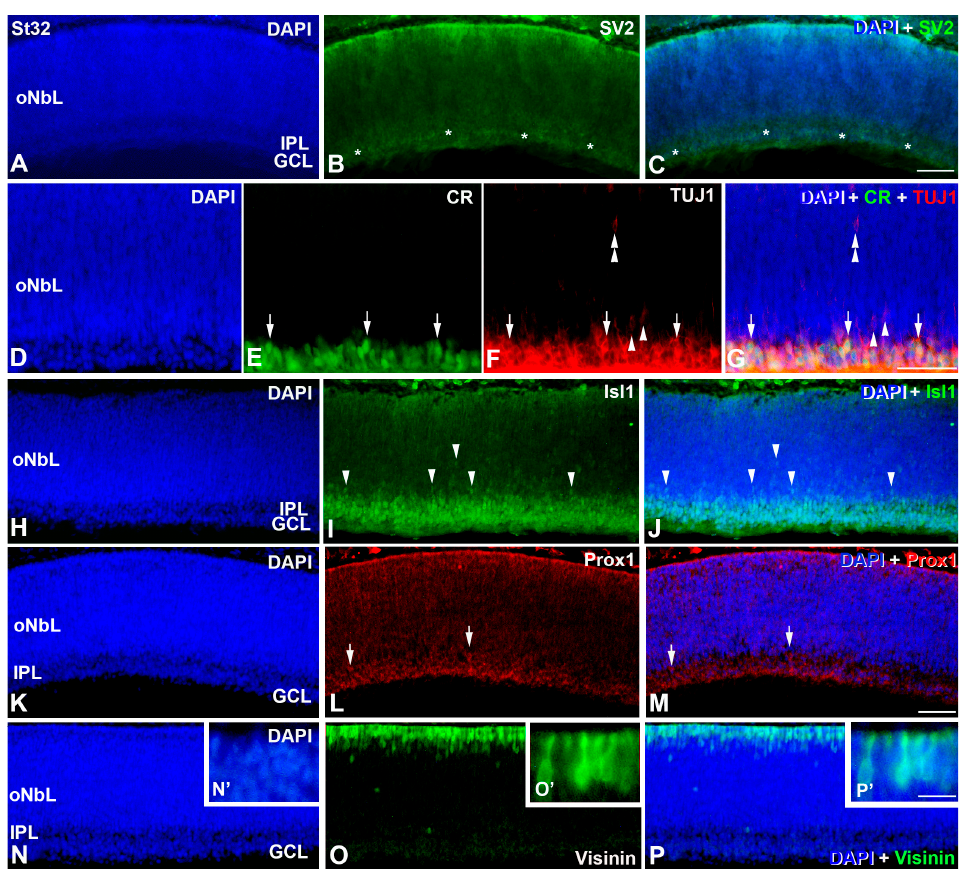
Figure 4. Immunodetection of different cell markers in retinal cryosections of C. coturnix at St32 of development. DAPI staining reveals an incipient emergence of the IPL ( A , E , H , K , N ). A faint immunostaining against SV2 is detected in the developing IPL (asterisks in ( B , C )). Most of the cells located in the GCL are doubly labeled for CR and TUJ1 (arrows in ( D – G )). Single TUJ1-labeled cells are also detected in the pGCL (arrowheads in ( F , G )) and in more external regions (double arrowheads in ( F , G )). A few rows of Isl1-positive nuclei can be observed in the pGCL ( I , J ). Sparse Isl1-immunopositive nuclei are also observed in more external regions (arrowheads in ( I , J )). Prox1-immunostaining localizes in the innermost region of the oNbL and in the GCL (arrows in ( L , M )), but also in more external regions of the oNbL (double arrowheads). Visinin-immunoreactive cells are mainly located in the more external region of the oNbL, but sparse labeled cells can be distinguished in more internal regions (arrowheads in ( O , P )). Visinin-positive cells clearly show a cell somata with a short external process ( O ′ , P ′ ). GCL, ganglion cell layer; IPL, inner plexiform layer; NbL, neuroblastic layer; oNbL, outer neuroblastic layer; pGCL, presumptive ganglion cell layer. Scale bars: 100 µm in ( A – P ); 30 µm in ( N ′ – P ′ ).